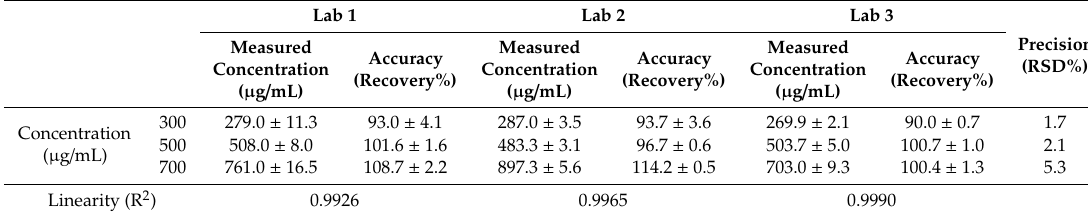
Table 2. Results of the cross-laboratory test for PVAc using HPLC–ELSD ( n = 3). Lab 1 Lab 2 Lab 3